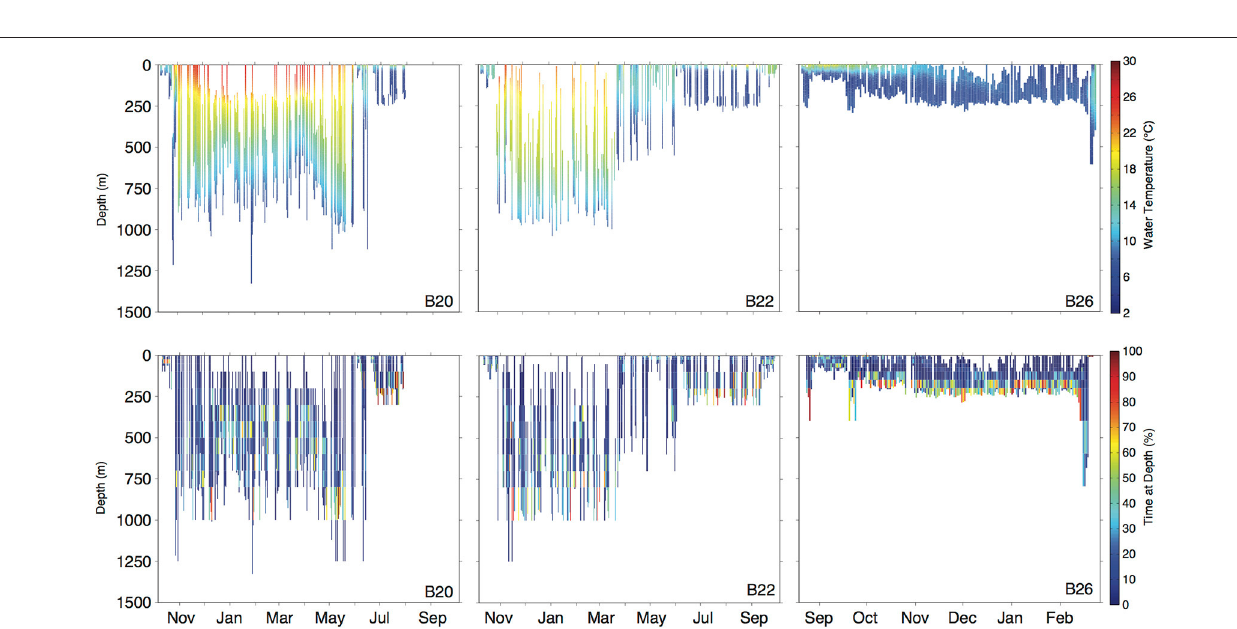
Frontiers in Marine Science | www.frontiersin.org